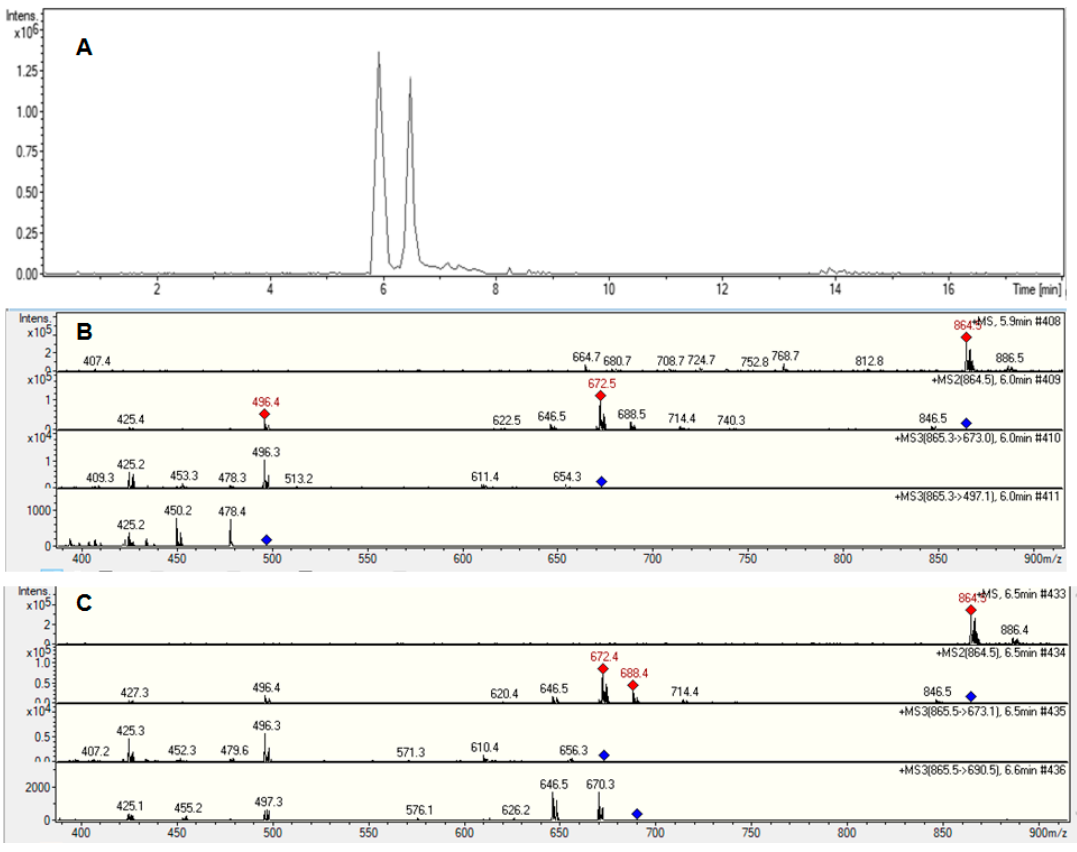
Figure 3. LC-MS/MS fragmentation experiments on Ga-DOTA-C21 complexes with m/z 864.5 [M + H] + . HPLC-MS chromatogram ( A ). Fragmentation pathway of the m/z 864.5 [M + H] + ion corresponding to the peak with retention time 5.9 min ( B ). Fragmentation pathway of the m/z 864.5 [M + H] + ion corresponding to the peak with retention time 6.5 min ( C ).